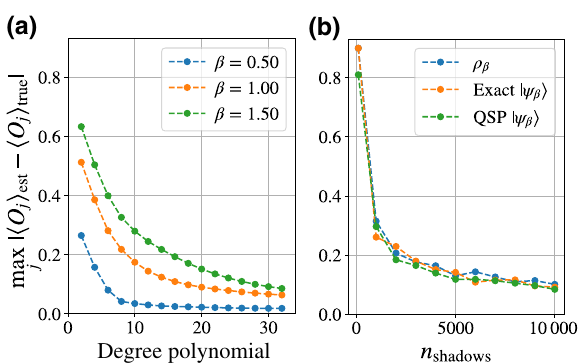
FIG. 2. The maximum error between the exact Gibbs-state expectation values, (cid:3) O j (cid:2) true = Tr O j ρ β , and the estimated expec- tation values (cid:3) O j (cid:2) est for all possible one- and two-qubit Pauli operators O j . (a) The expectation values estimated directly on thermal pure quantum states, | ψ β (cid:2) , generated with QSP for different inverse temperatures β as function of the degree of the polynomial approximation. (b) A comparison of the errors between shadows constructed directly from the true Gibbs state, ρ β , and shadows constructed from the exact TPQ states and the TPQ states generated with QSP: β = 1 and polynomial degree d = 32.